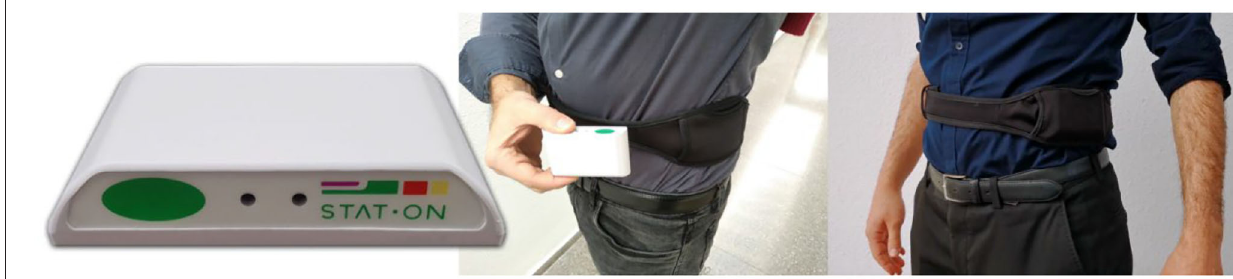
FIGURE 2 | STAT-ON TM and its location and orientation.